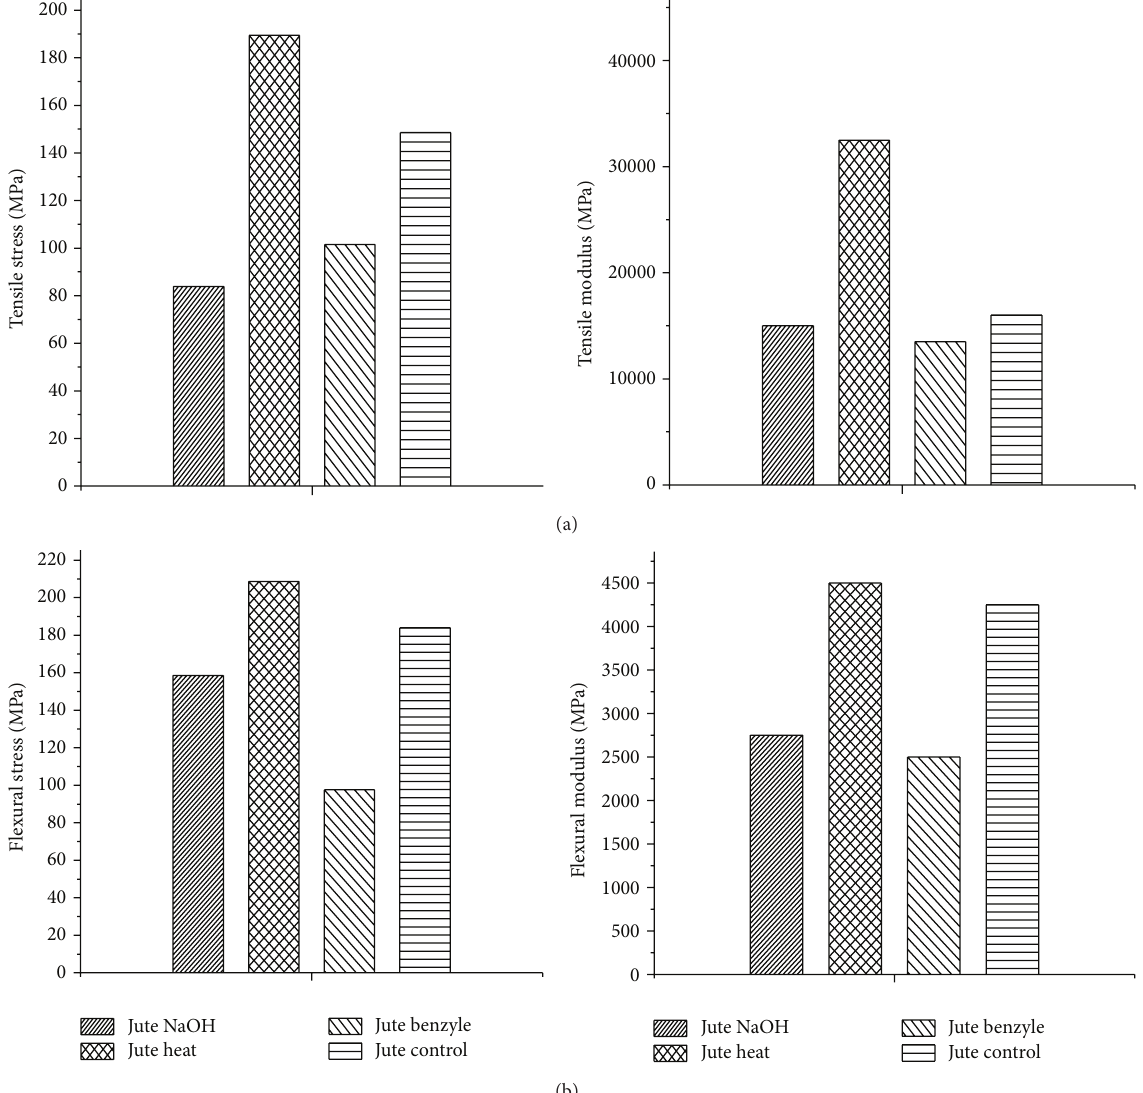
Figure 3: (a) Tensile behaviour of jute FRP composite, woven jute being subjected to different pretreatments; (b) flexural behaviour of jute FRP composite, woven jute being subjected to different